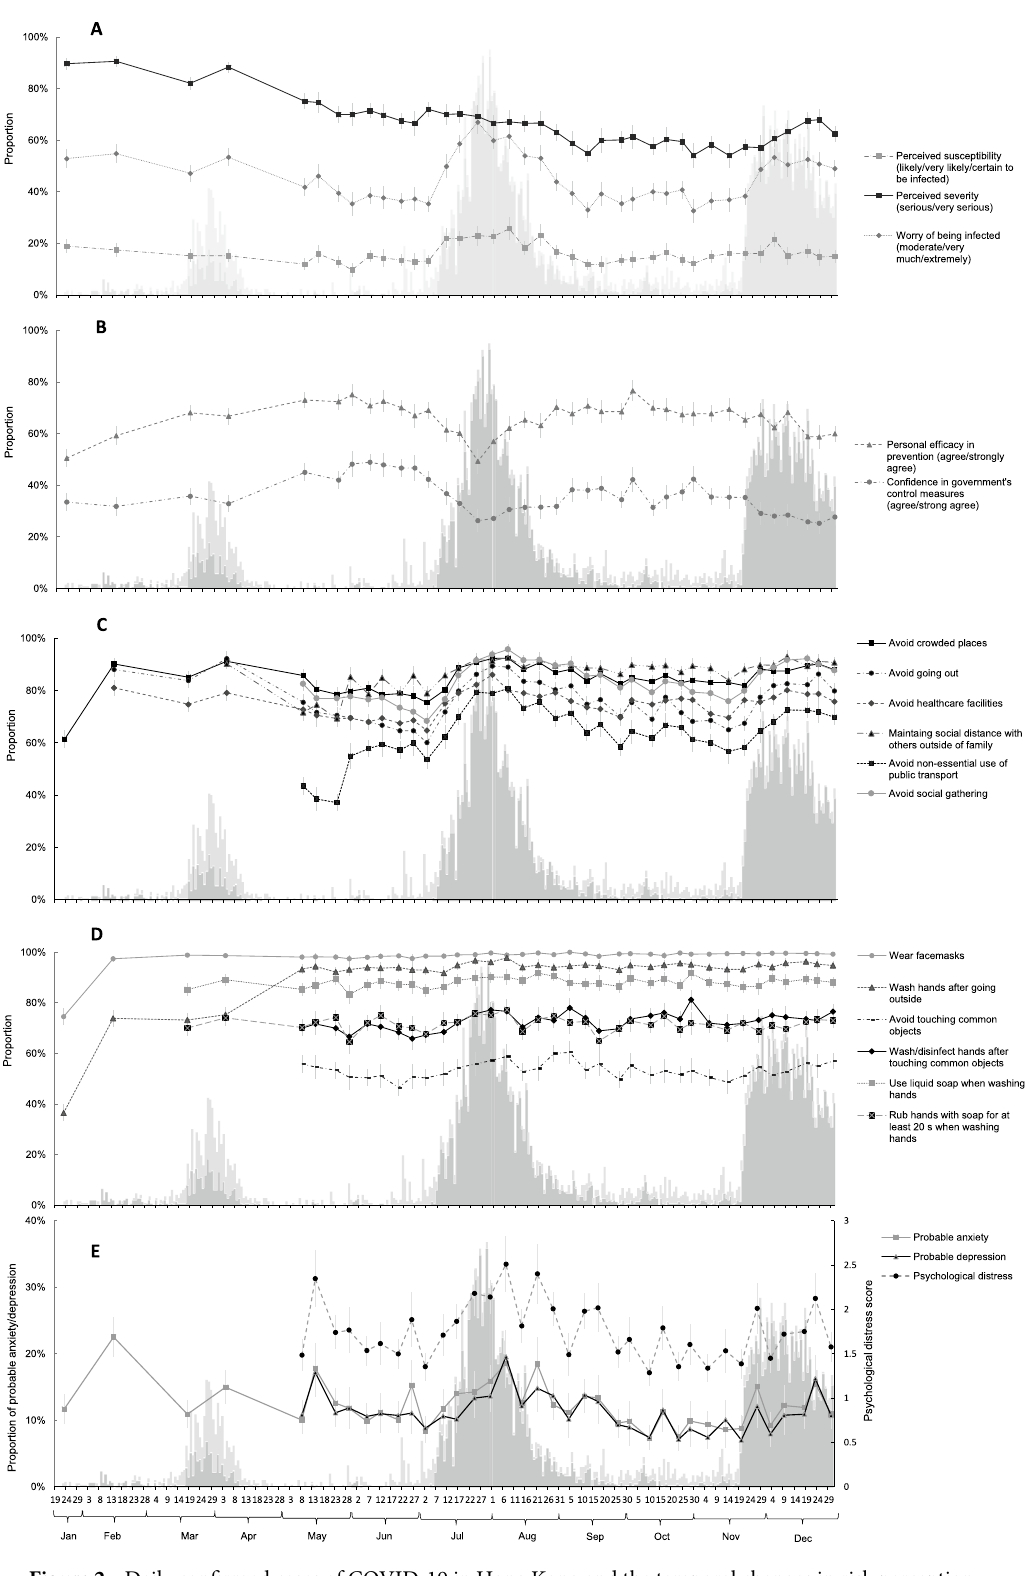
Figure 2. Daily confirmed cases of COVID-19 in Hong Kong and the temporal changes in risk perception of COVID-19 ( A ), personal efficacy in the prevention of COVID-19 and confidence in government’s control measures ( B ), probable anxiety, probable depression and overall psychological distress ( C ), adoption of physical distancing behaviours ( D ) and adoption of personal hygiene practices ( E